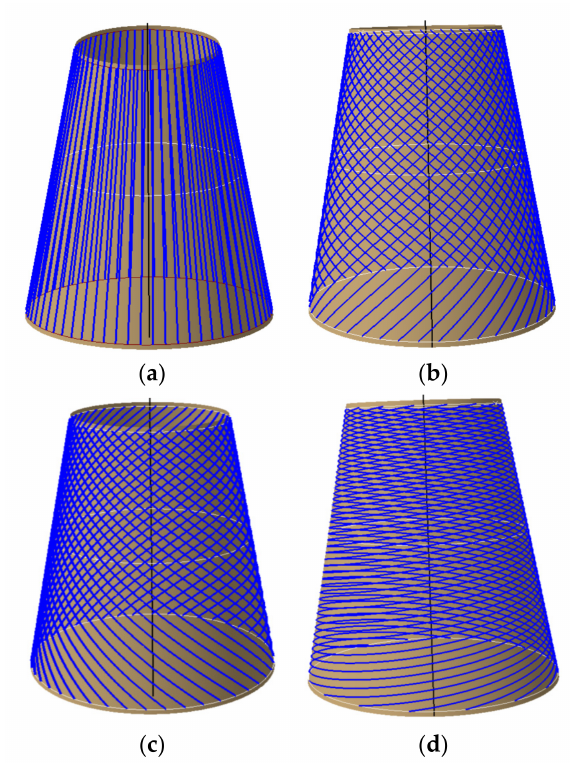
Figure 11. Four typical angle plies based on circumferential averaging. ( a ) 0 ◦ Ply. ( b ) 45 ◦ Ply. ( c ) − 45 ◦ Ply. ( d ) 80 ◦